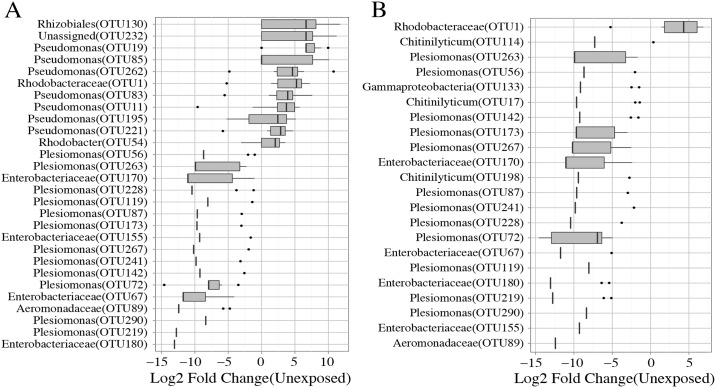
Triclosan exposure is associated with significant alterations in OTU abundance.Fold change values for OTUs that were significantly altered in abundance in the (A) four-day, and (B) seven day exposure groups. Genus level taxonomic assignments are provided and corresponding OTU IDs indicated inside parentheses.